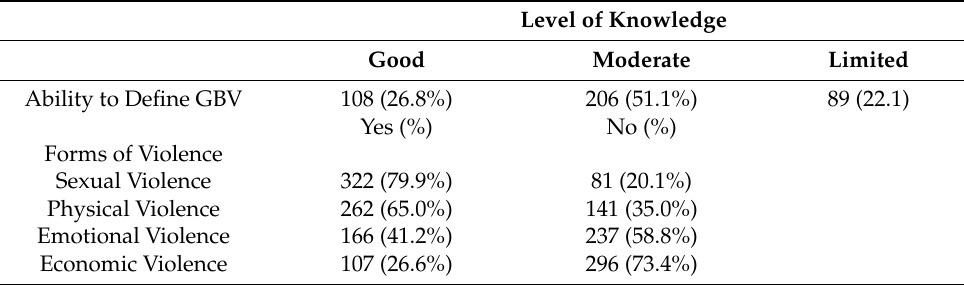
Table 2. Knowledge of gender-based violence definition among